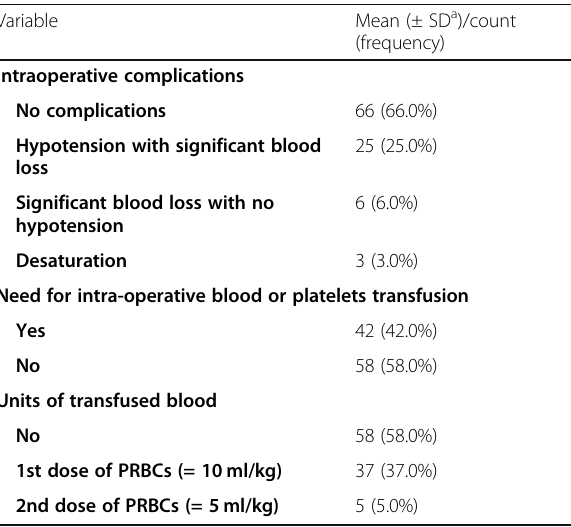
Table 3 Intraoperative complications. Data presented as mean ± standard deviation (SD), count, and